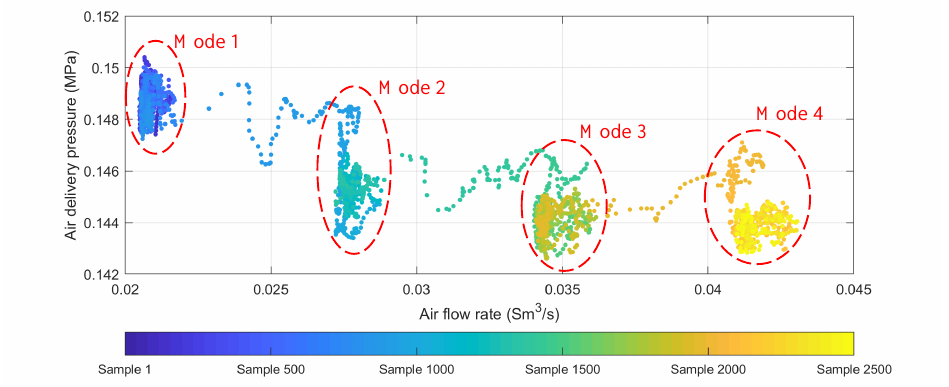
Figure 7. Illustration of multi-modality in process